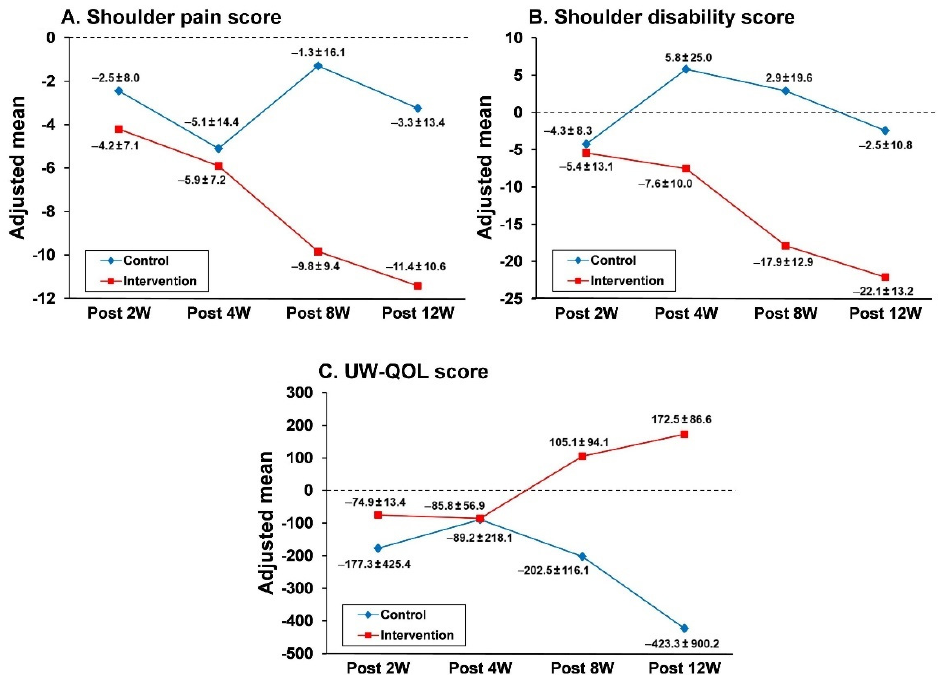
Figure 3. Changes in adjusted mean scores for shoulder pain ( A ), shoulder disability index ( B ), and UW-QOL ( C ) over time during the study period. Adjusted mean scores were estimated using the analysis of covariance (ANCOVA) model in Table 3 and were expressed as absolute values. UW- QOL, University of Washington Quality of Life Questionnaire. Post 2W, 4W, 8W, and 12W represent assessments at 2, 4, 8, and 12 weeks after surgery, respectively.